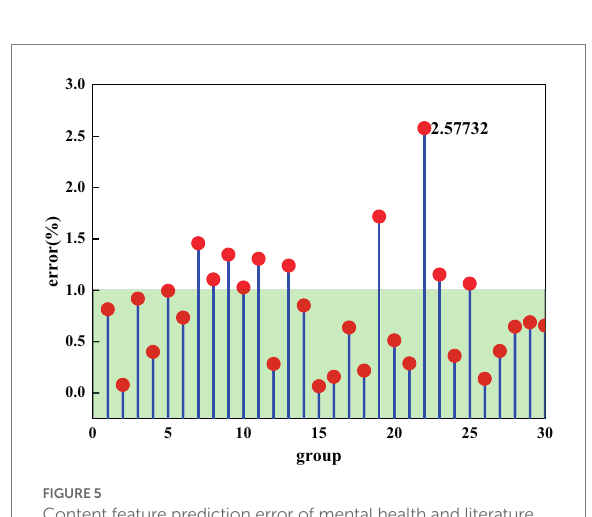
FIGURE 5 Content feature prediction error of mental health and literature dissemination